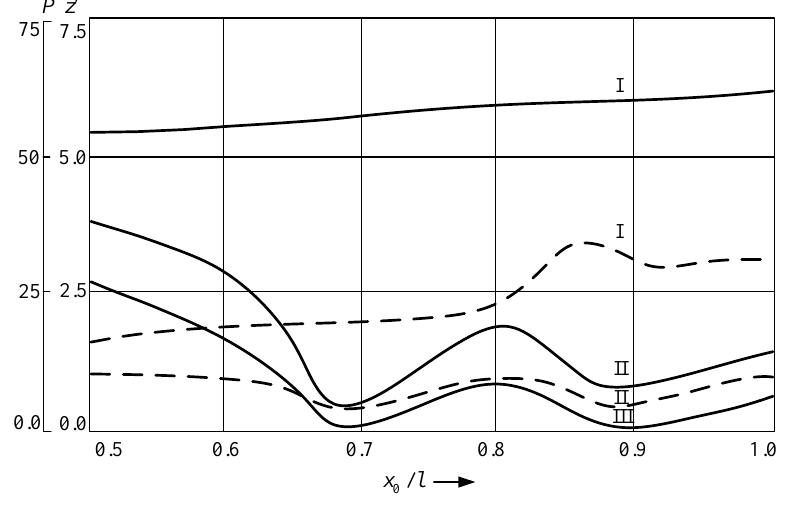
Figure 11. Dependence of contact pressure force P of the cantilever microstructure on the position of the support.  of the